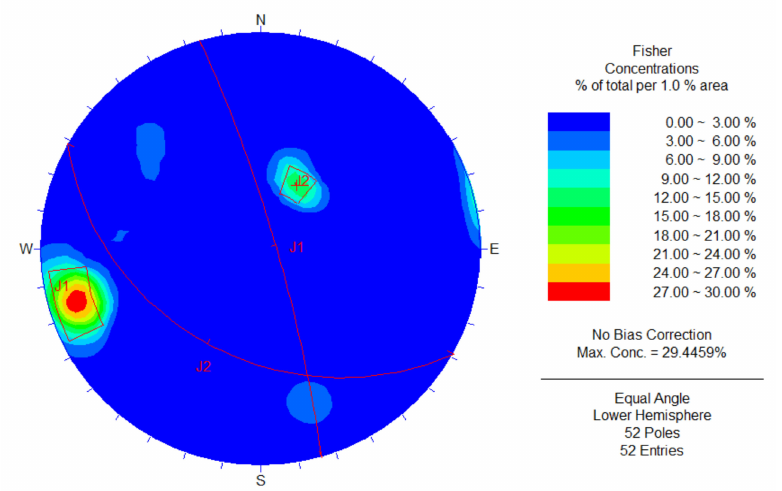
Figure 3. Pole plot of the discontinuities in the footwall (red rectangles denote the most developed region of the dominant discontinuity